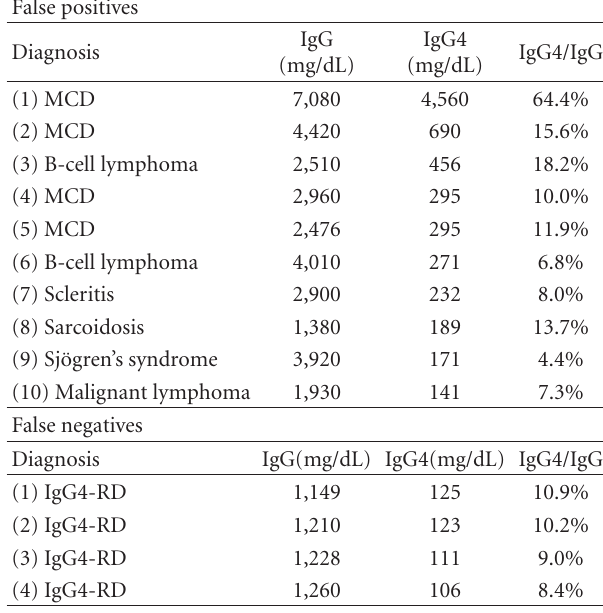
Table 2: Serum IgG and IgG4 concentrations and IgG4/IgG4 ratio of patients with false-positive and false-negative diagnoses of IgG4- RD.